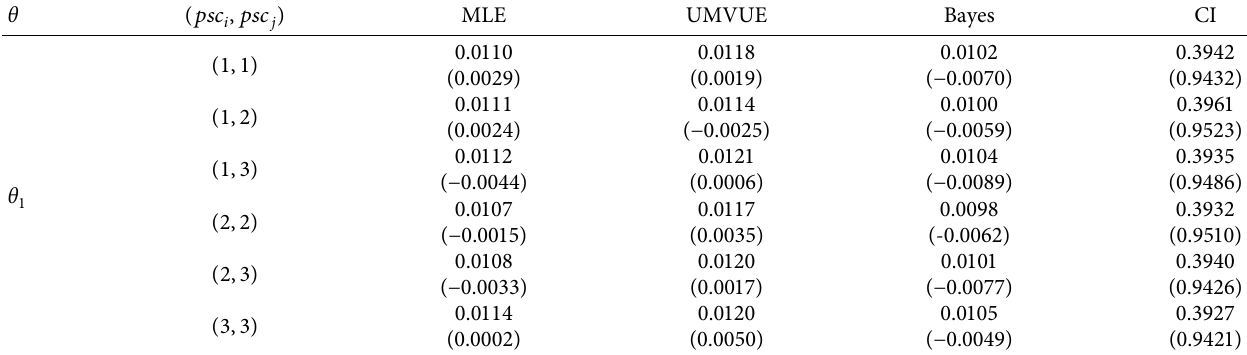
Table 4: Compute MSE (bias) of the estimations and the average confidence length (coverage percentage), set σ �